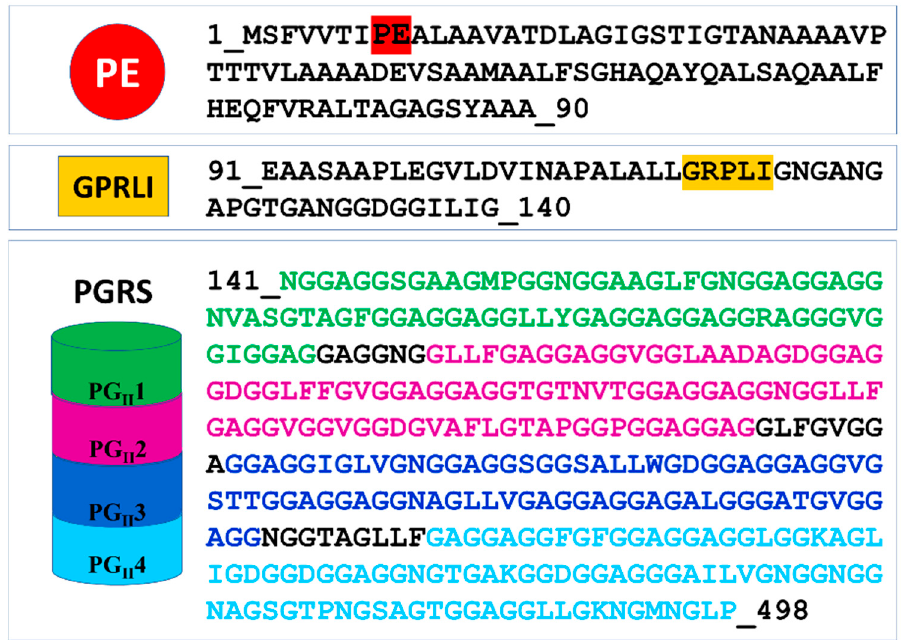
Figure 1. Domain organization and sequence of PE_PGRS33. In the PE domain, the conserved PE motif is colored red. In the PGRS domain, sequences of the four PG II sandwich motifs are colored green, purple, blue, and cyan.